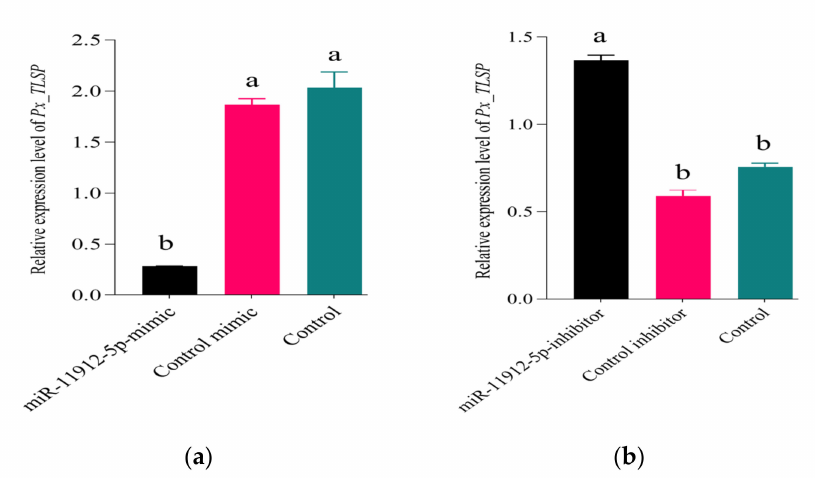
Figure 5. RT-qPCR expression levels of Px_TLSP in P. xylostella larvae fed on ( a ) miR-11912-5p-mimic, control mimic, control, and ( b ) miR-11912-5p-inhibitor, control inhibitor, and control. Error bars show 95% confidence intervals (CI). Letters indicate significant differences at p <